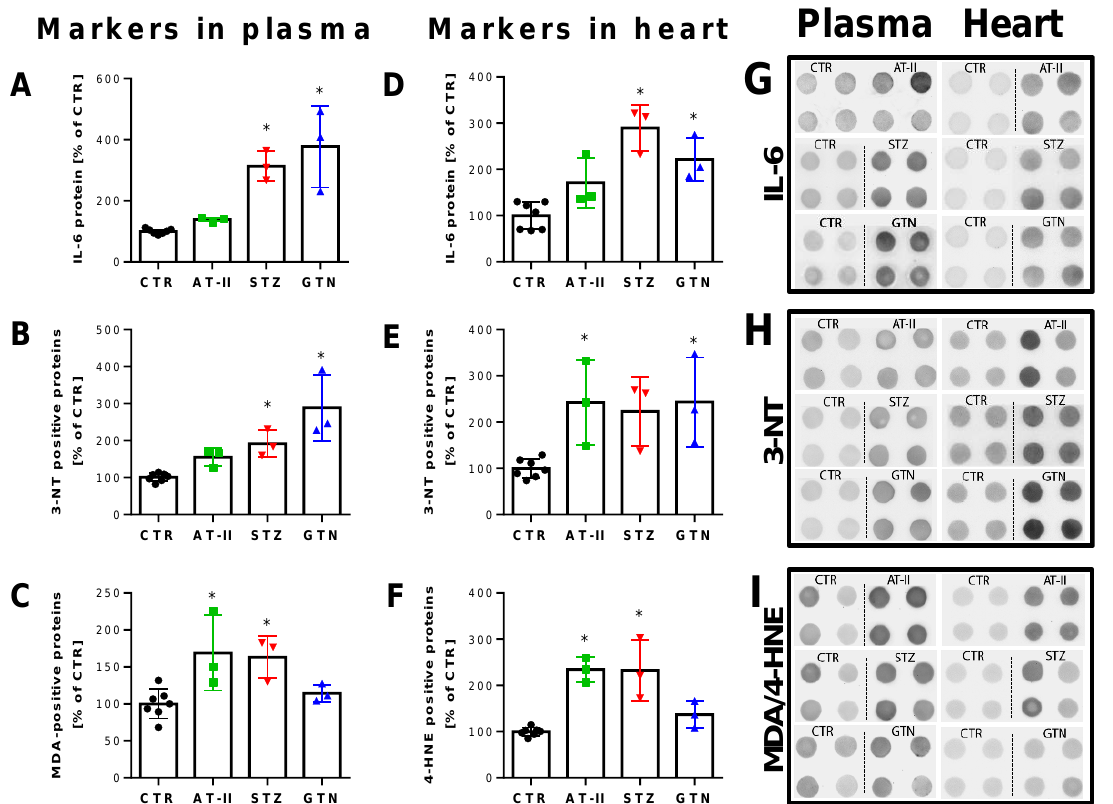
Figure 7. Biomarkers in plasma and heart from rats with preestablished cardiovascular disease or pharmacologically induced oxidative stress. Markers of oxidative stress (3-NT, MDA, 4-HNE) and inflammation (IL-6) were increased in plasma ( A – C ) and heart ( D – F ) of hypertensive, diabetic and nitrate tolerant rats as compared to control animals. Original blots are shown on the right for 4 technical replicates per group ( G – I ). Data are mean ± SD of 7 (Ctr) and 3 (AT-II, STZ, GTN) rats per group. Each single animal data point was generated from 2–4 technical replicates. * p < 0.05 vs. control group.